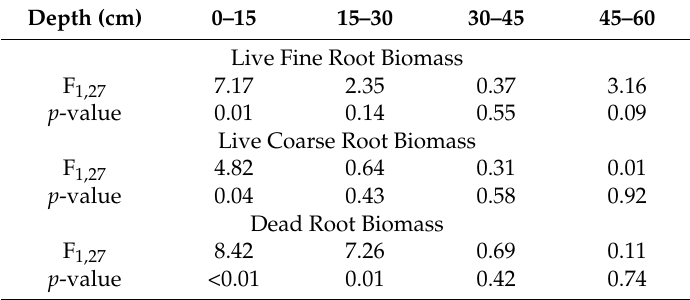
Table 5. Statistical summary of the influence of treatment on mean root biomass by type and depth as measured in three 26-year-old longleaf pine ( Pinus palustris Mill.) stands. Summaries given for the comparison of root biomass from soil beneath control collars versus soil within root exclusion tubes. Bolded p -values are significant at α =